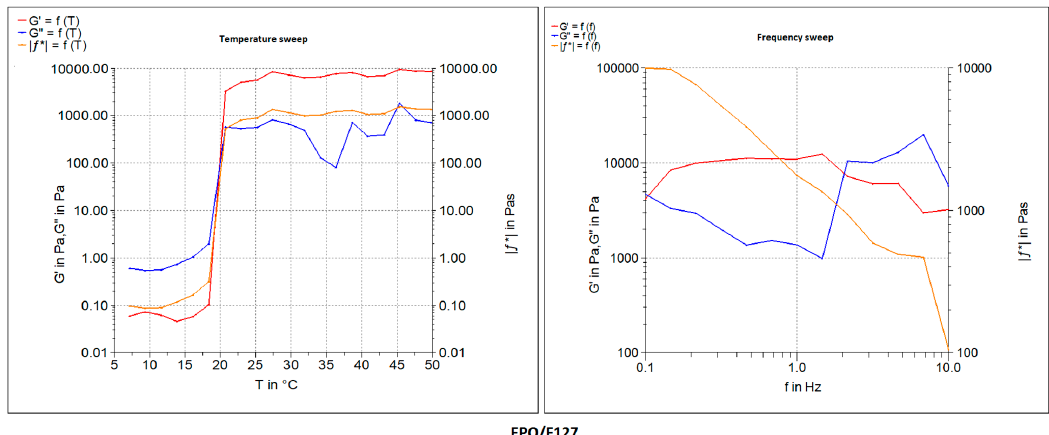
Figure 3. Rheology data of the bioink formulations represented by storage modulus (G ′ ) and loss modulus (G ′′ ) both in temperature (test run at 5–50 °C) and frequency sweeps (test run at 25 °C) for formulation F127/EPO 4:1.